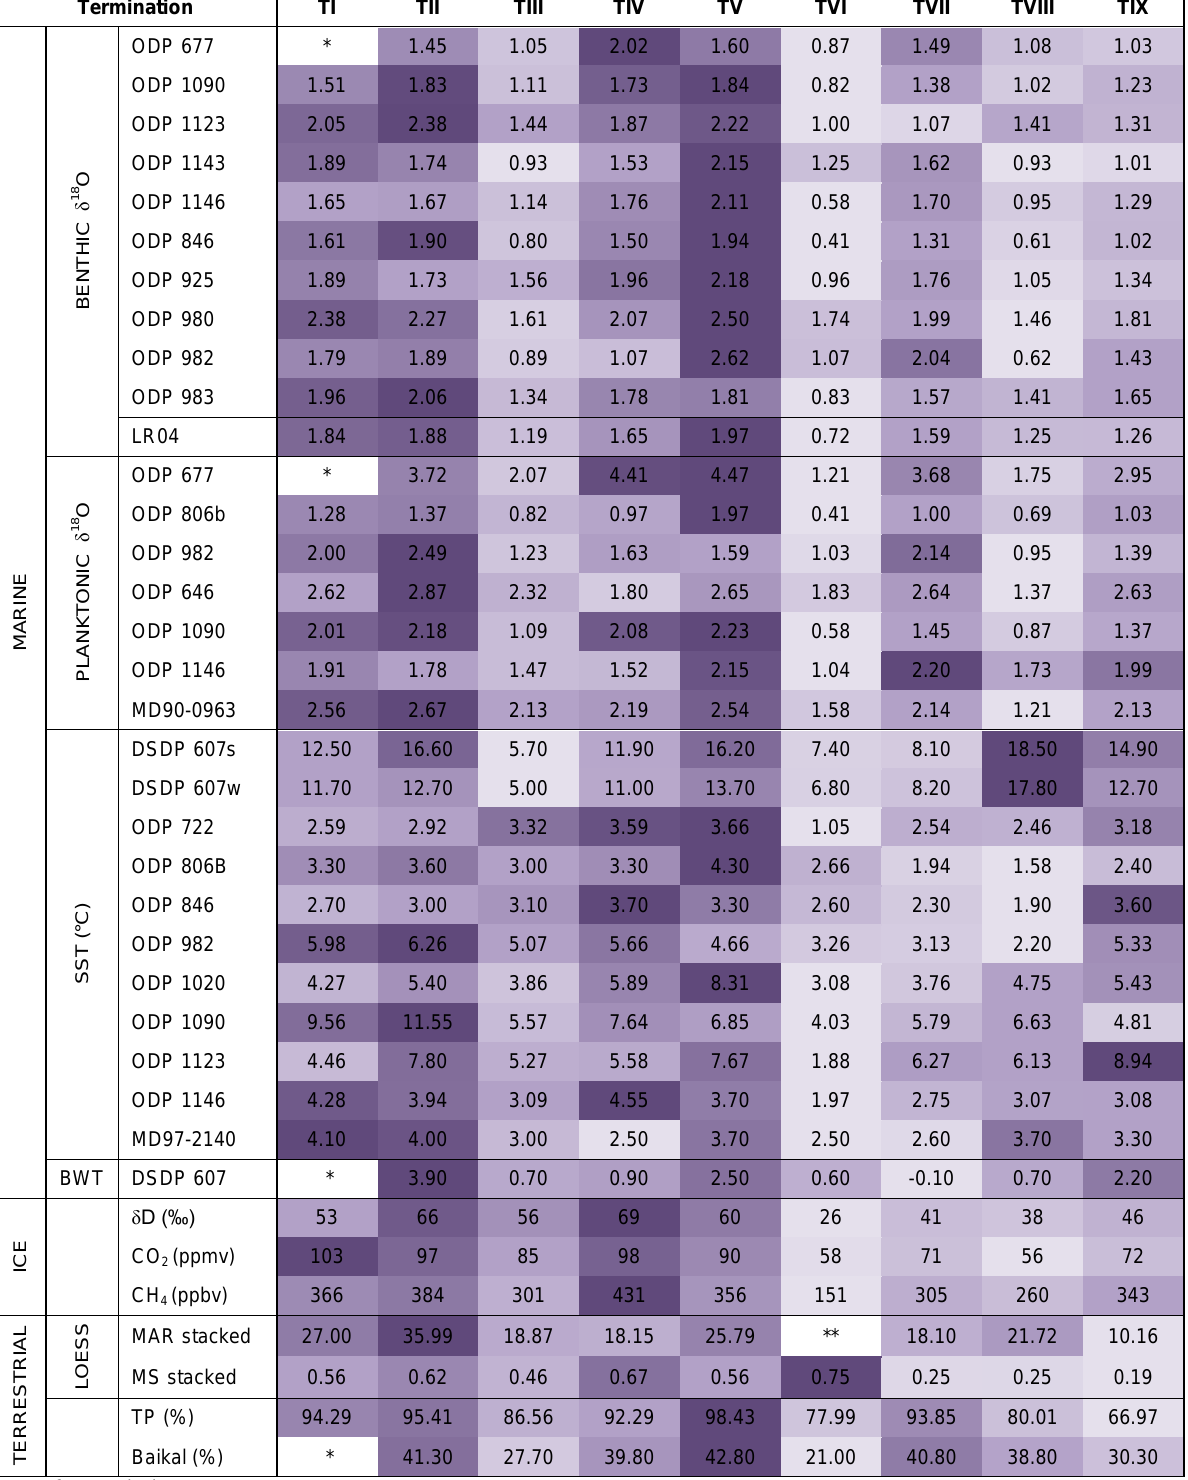
Table 5 - Maximum amplitude values for each termination. Termination amplitude is the difference between maximum glacial and interglacial values for each glacial-interglacial transition. The values are colour-coded according to strength, with deep purple being the greatest, and pale purple the weakest, termination amplitude for each record.